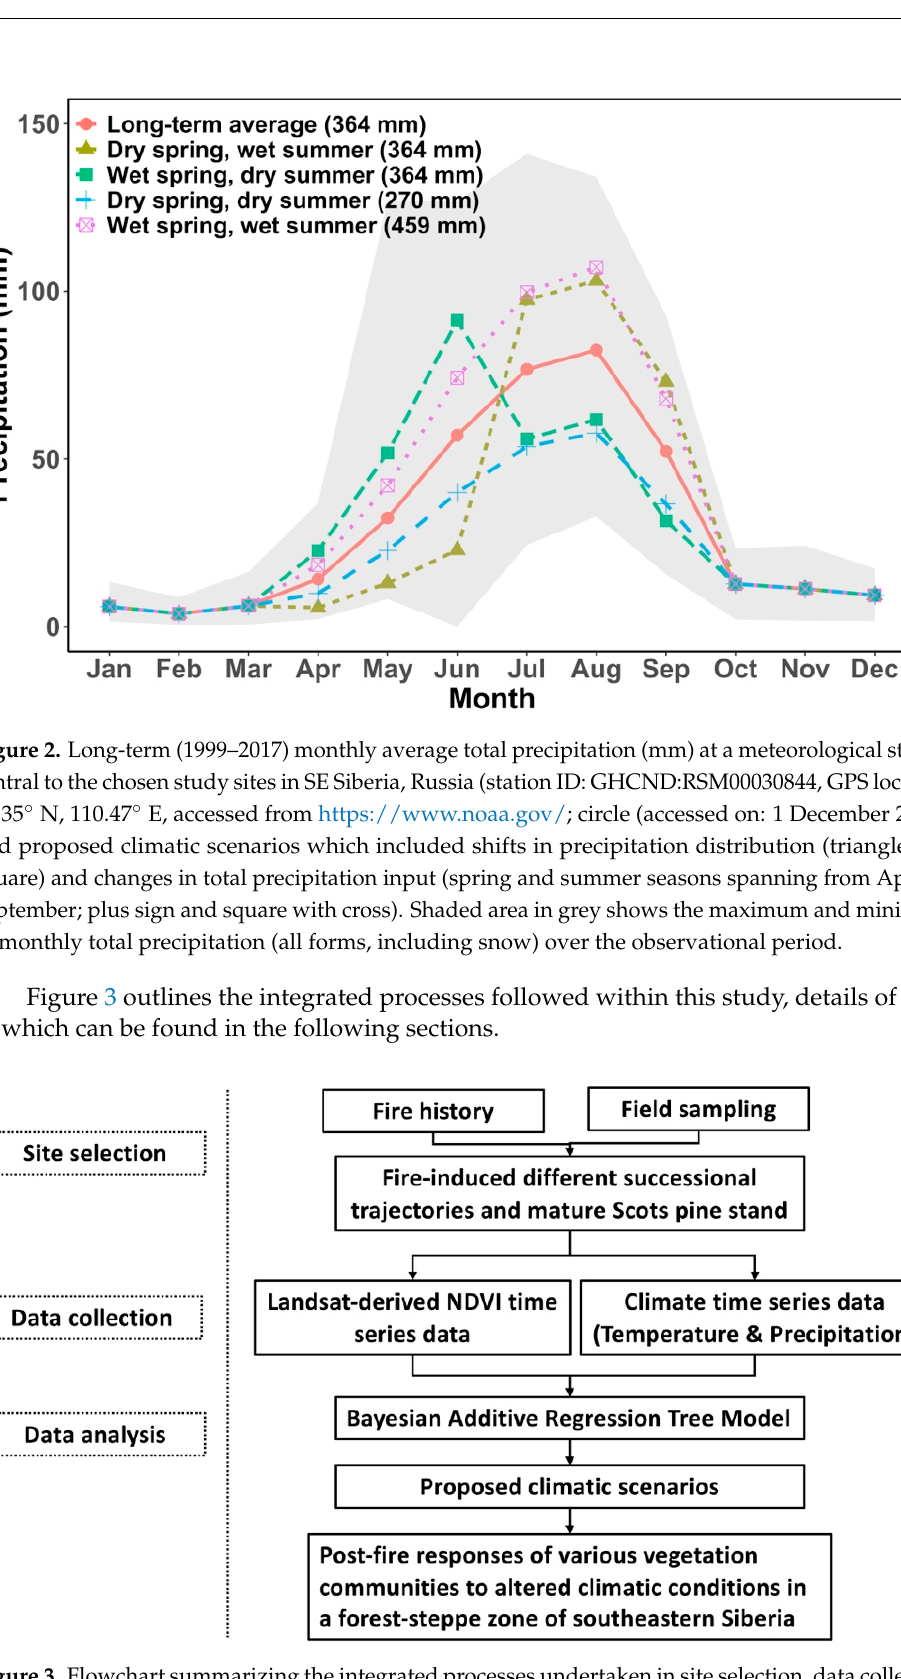
Figure 3. Flowchart summarizing the integrated processes undertaken in site selection, data collection and subsequent data analysis in the present study.